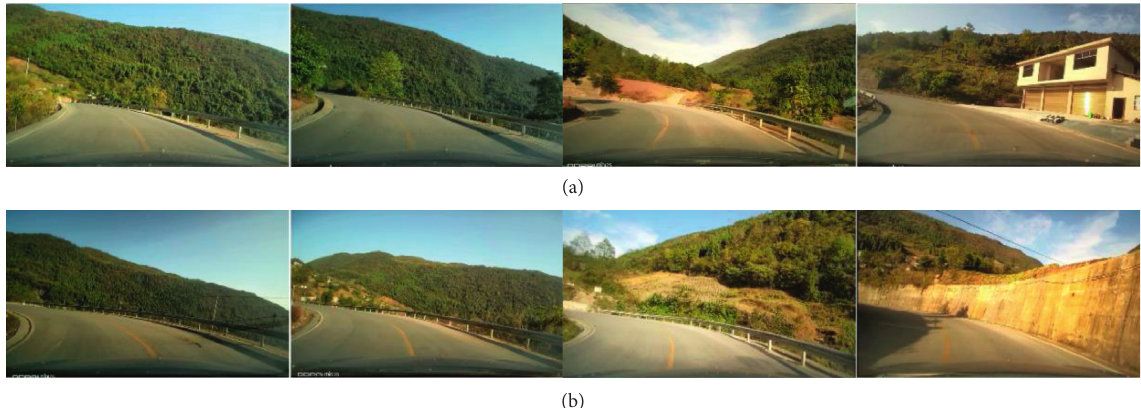
Figure 13: Exposure of the vehicle to the opposite lane. (a) Driving on downslope hairpin curves. (b) Driving on upslope hairpin